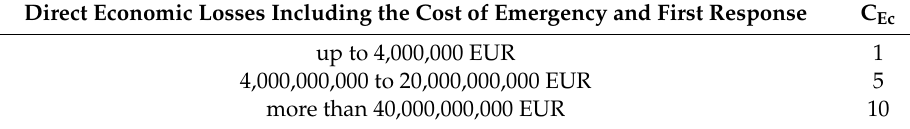
Table 5. Consequence on the economy coe ffi